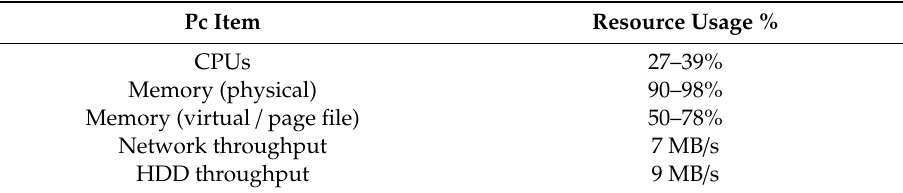
Figure 8. The proposed scheme latency test. Table 2. Network resource monitoring.